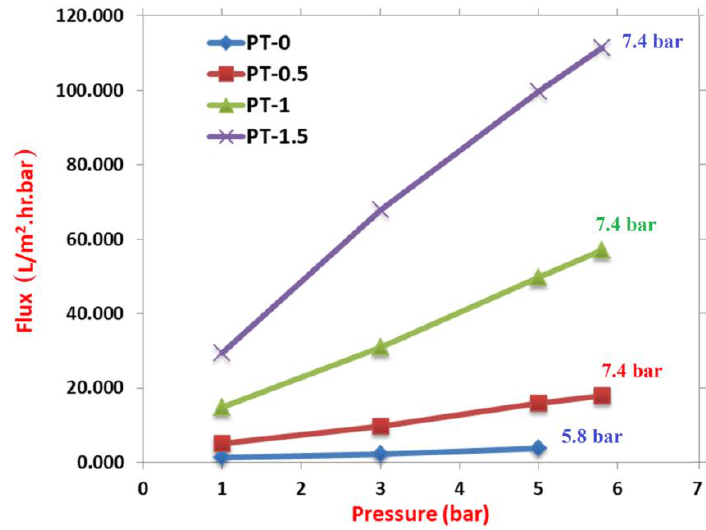
Figure 11. Effect of the feeding pressure on the pure water flux of the PVC membranes at different TiO 2 amounts: (PT-0) 0 gm TiO 2 ; (PT-0.5) 0.5 gm TiO 2 ; (PT-1) 1 gm TiO 2 ; and (PT-1.5) 1.5 gm TiO 2 .